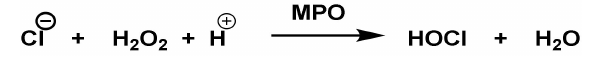
Figure 6. Catalyzed conversion of H 2 O 2 and chloride to